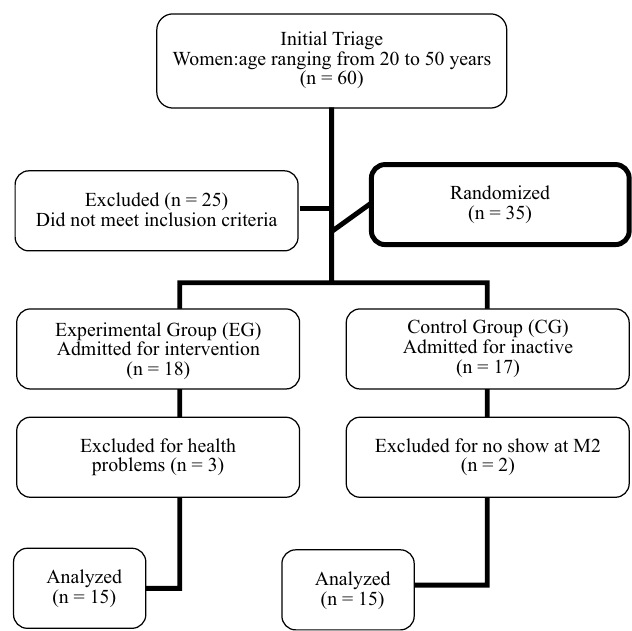
Figure 1.Randomization and subject